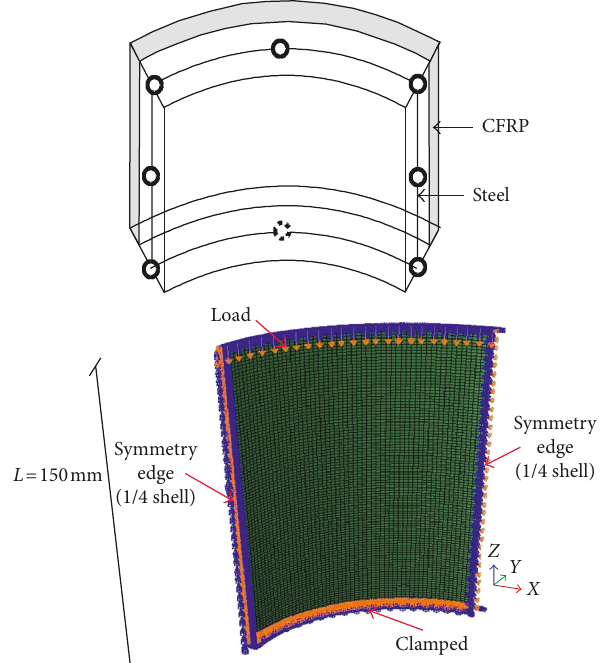
Figure 13: The multilayer shell model.